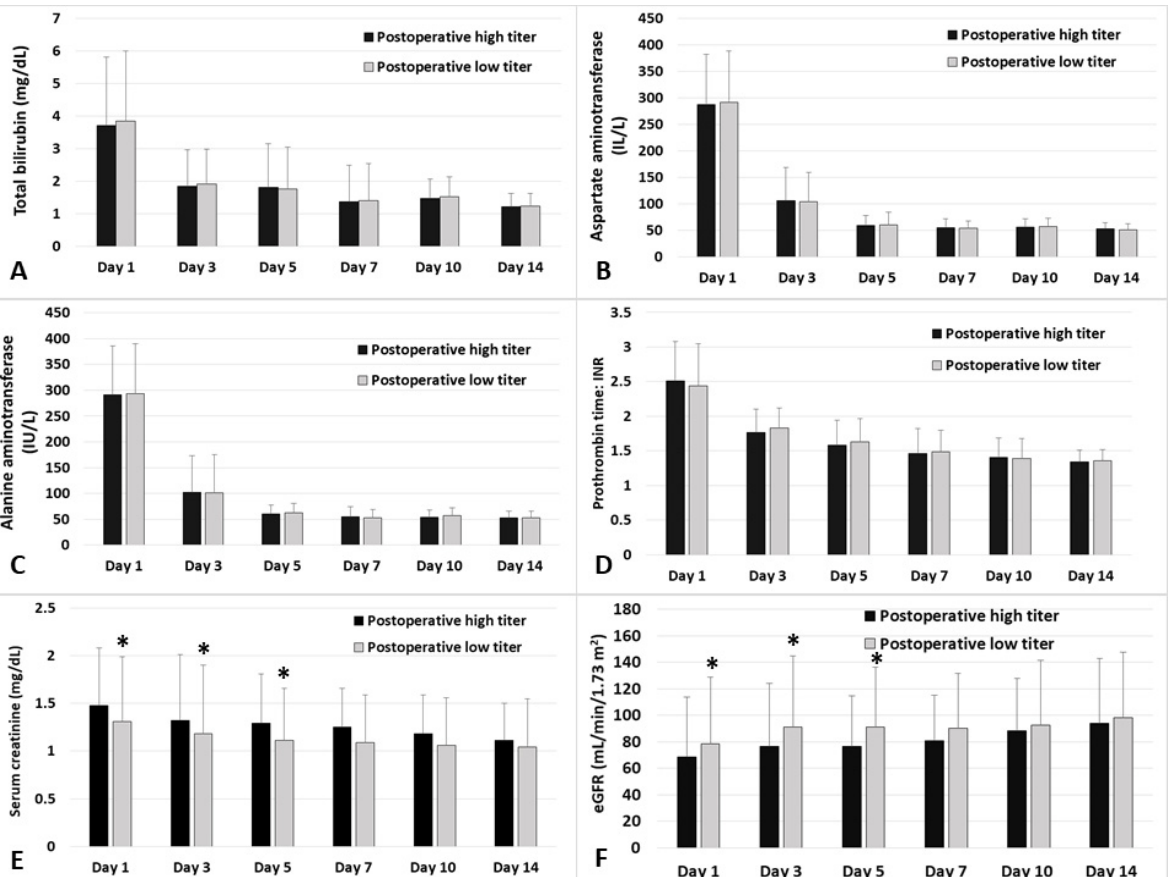
Figure 4. Laboratory results after liver transplantation between the high and low postoperative peak Ig M isoagglutinin titer groups (high group: peak Ig M titer ≥ 32; low group: peak Ig M titer ≤ 16). Laboratory values, including total bilirubin ( A ), aspartate aminotransferase ( B ), alanine aminotransferase ( C ), prothrombin time: international normalized ratio ( D ), serum creatinine ( E ), and estimated glomerular filtration rate ( F ) are depicted during postoperative day 1 to 14. * = significant difference between groups ( p < 0.05); Ig = immunoglobulin; eGFR = estimated glomerular filtration rate. The top edge of each box shows the mean value, and the error bar shows standard deviation.